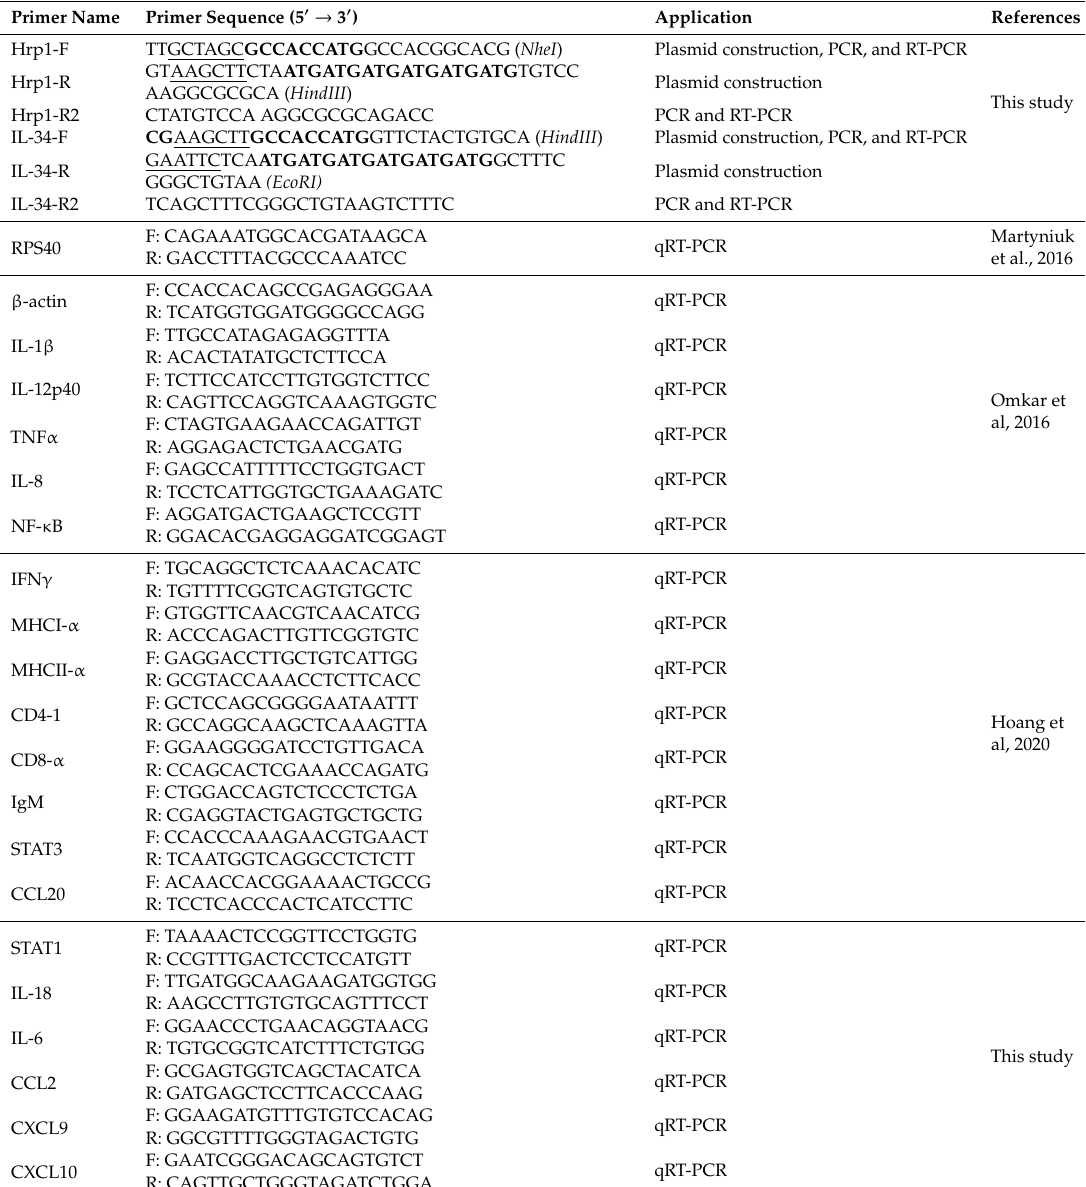
Table 1. Primers used in this